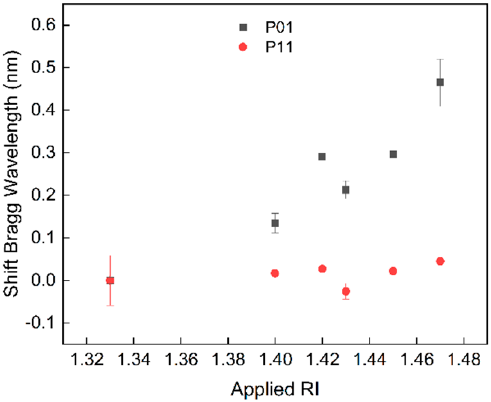
Figure 4. Bragg wavelength shift for the highest ( P01 ) and lowest ( P11 ) PMG for different SRI solutions.